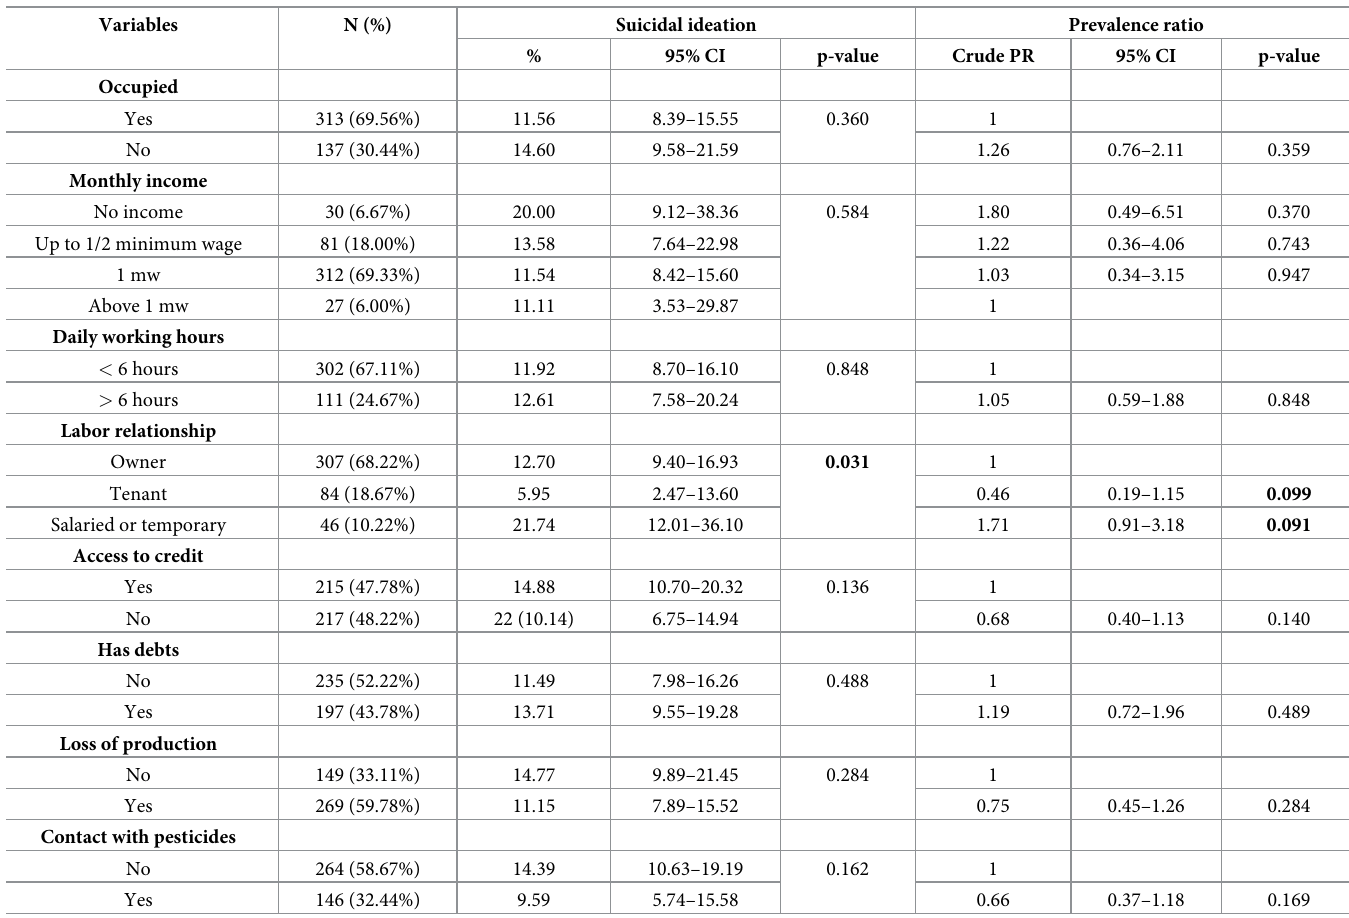
Table 3. Descriptive and bivariate analysis between suicidal ideation and its association with aspects of income and work of farmers in the city of Caico´-RN. Variables